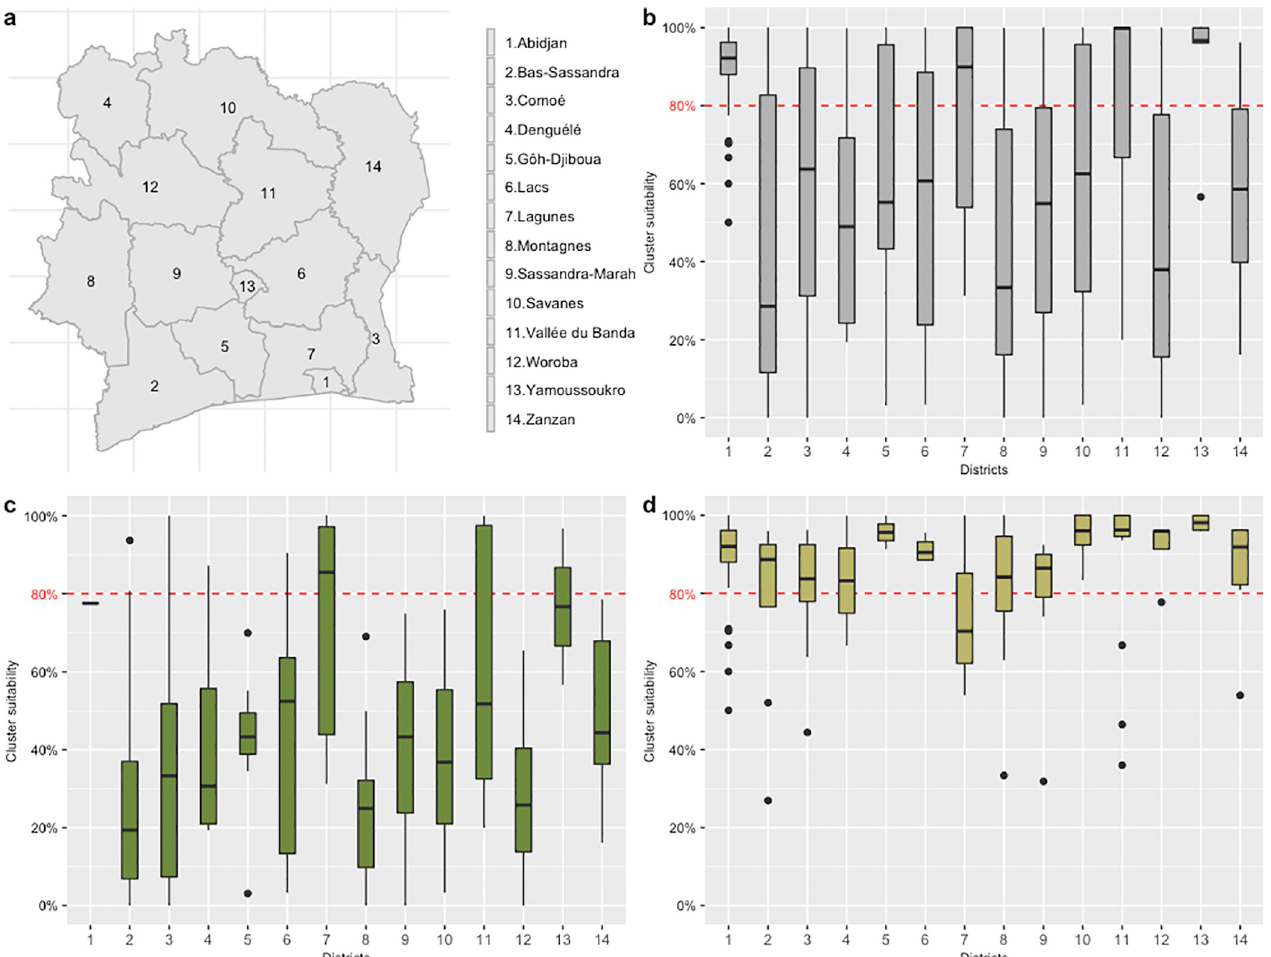
Fig 3. a-District locations; b-Rural and Urban clusters; c-Rural clusters; d-Urban clusters. The boxplots represent the cluster suitability (% of households with appropriate materials within a cluster) aggregated into districts. Middle lines are the median, box ranges from first to the third quartile, and whiskers indicates min and max. Black filled circles are outliers. The red dotted line marks the 80% desired suitability for the intervention. Basemap: https://data.humdata.org/ dataset/cote-d-ivoire-administrative-level-0-3-boundaries-and-points.